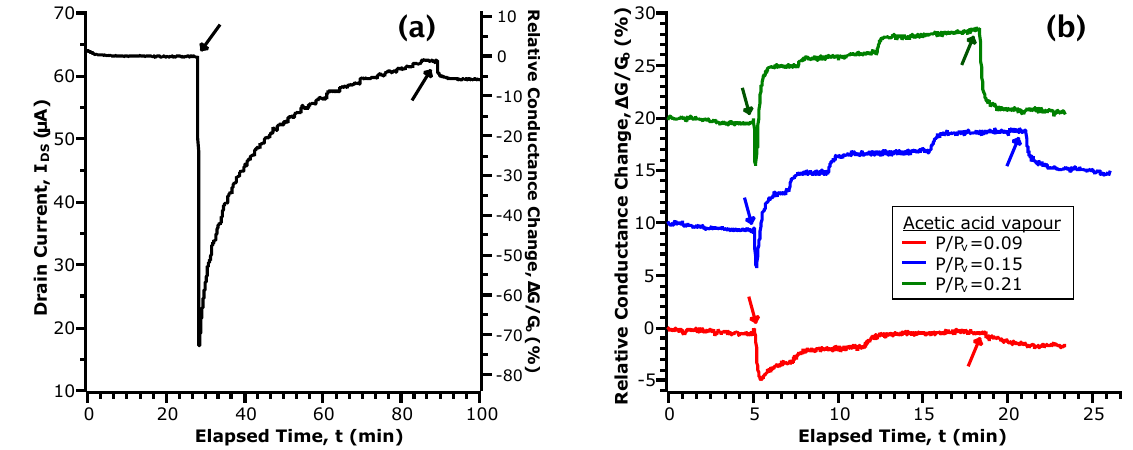
Figure 3. Selected portions of the transient response of I DS upon exposure to acetic acid vapour. The downward and upward facing arrows indicate the time that vapour was introduced and removed from the chamber, respectively. ( a ) shows the initial response of our device; ( b ) shows the response in three concentrations of vapour, normalized by the baseline conductance prior to exposure. For clarity, the curves are shown with an offset of 10% relative to each